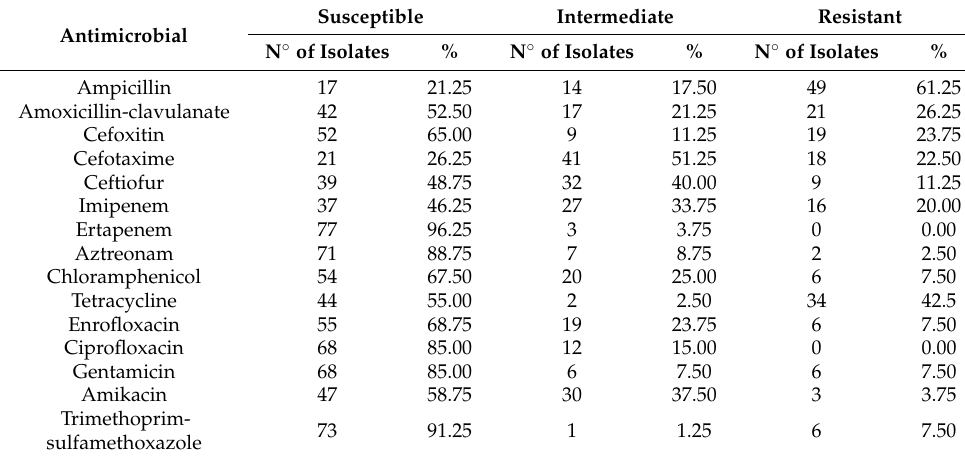
Table 2. Results of disk diffusion test for